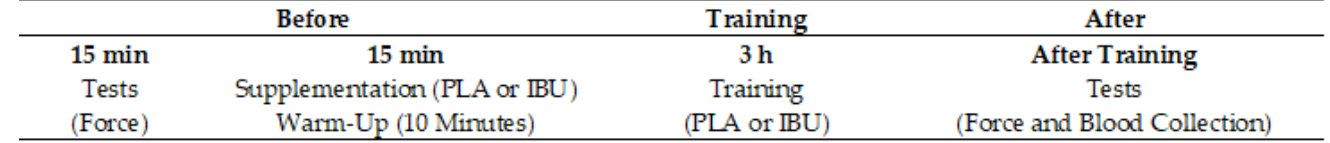
Figure 2. Intervention timeline.